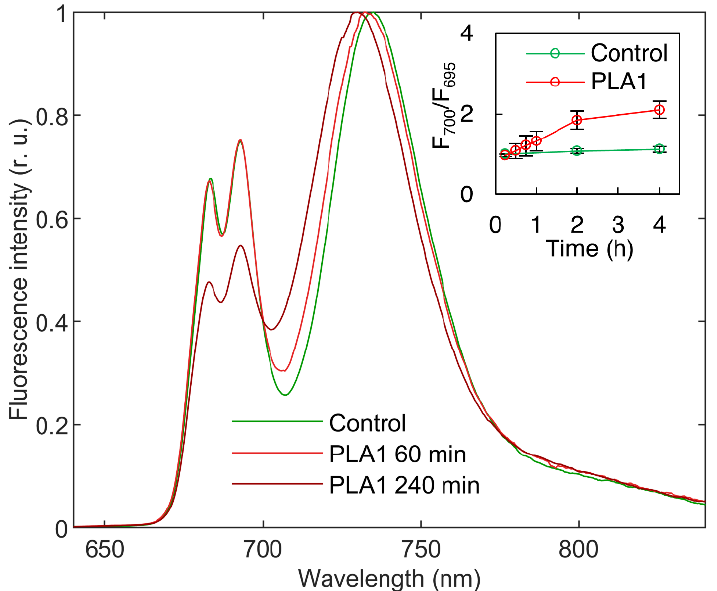
Figure 3. Typical 77 K Chl- a fluorescence emission spectra of isolated spinach thylakoid membranes; untreated (green) and treated with 2 U mL − 1 PLA1 for 60 min (light red) and 240 min (dark red). Excitation wavelength, 475 nm; the spectra were normalized to the maximal intensities of the fluorescence emission. Inset shows the variations in the F 700 /F 695 ratio as a function of time, relative to the control. Mean values and standard deviations are from three independent